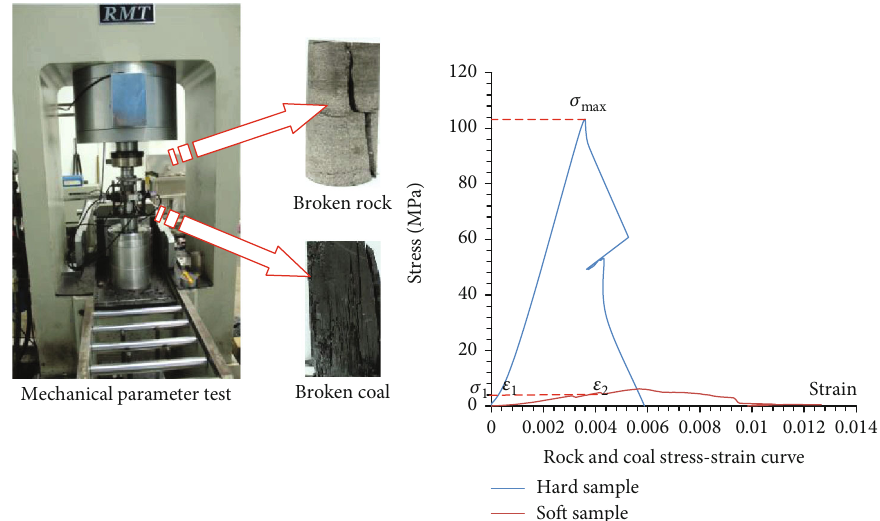
Figure 5: Mechanical test and stress-strain curves of samples with di ff erent strength.